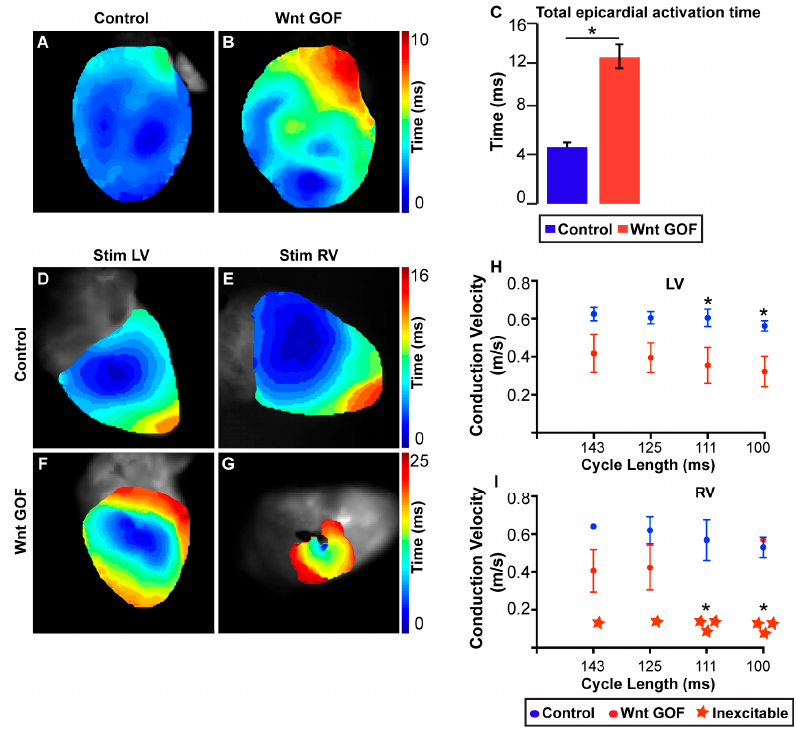
Figure 1. Ectopic Wnt activation differentially affects the electrical phenotype of RV versus LV. ( A , B ) Reconstructed electrical activation pattern from optical mapping experiment during sinus rhythm in control ( A ) and Wnt GOF ( B ) mice. ( C ) Total epicardial activation time is significantly prolonged in Wnt GOF mice (4.4 ± 0.4 versus 11.5 ± 1.0 ms, n = 4 each genotype). ( D – G ) Representative electrical activation pattern of the LV and RV during epicardial stimulation in control ( D , E ) and Wnt GOF ( F , G ) mice. ( H ) Left ventricular (LV) longitudinal conduction velocity of Wnt GOF mice was slower during stimulation at each cycle length, and the difference between the two genotypes became larger at faster pacing rates (111 and 100 ms cycle lengths, n = 4). ( I ) Right ventricular (RV) longitudinal conduction velocity of Wnt GOF mice was also slower, and was more severely decreased than in the LV. One Wnt GOF mutant had an electrically inexcitable RV when paced at 143 ms cycle length, while two others had markedly decreased conduction velocity at slower cycle lengths and became inexcitable at pacing rates above 125 ms cycle interval. This is consistent with decremental conduction, a property of AV canal and AV nodal tissues. Note the different time scales between each experiment. Data are represented as mean ± SEM. Group comparison for conduction velocity was performed using a Student’s unpaired 2-tailed t -test at each cycle length. Group comparison for inexcitability was performed using a Chi squared test without Yate’s correction. * p < 0.05. Modified from Gillers et al., Canonical Wnt Signaling Regulates Atrioventricular Junction Programming and Electrophysiological Properties, Circulation Research, Volume 116, Issue 3, page 402.